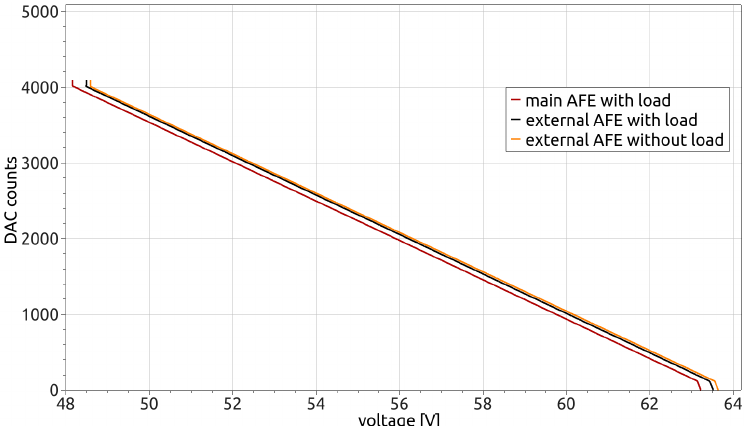
Figure 16. DAC code that sets supply voltage, x-axis, vs. main and external AFE SiPM voltage (with and without 10.48 M Ω of resistive load), y-axis.